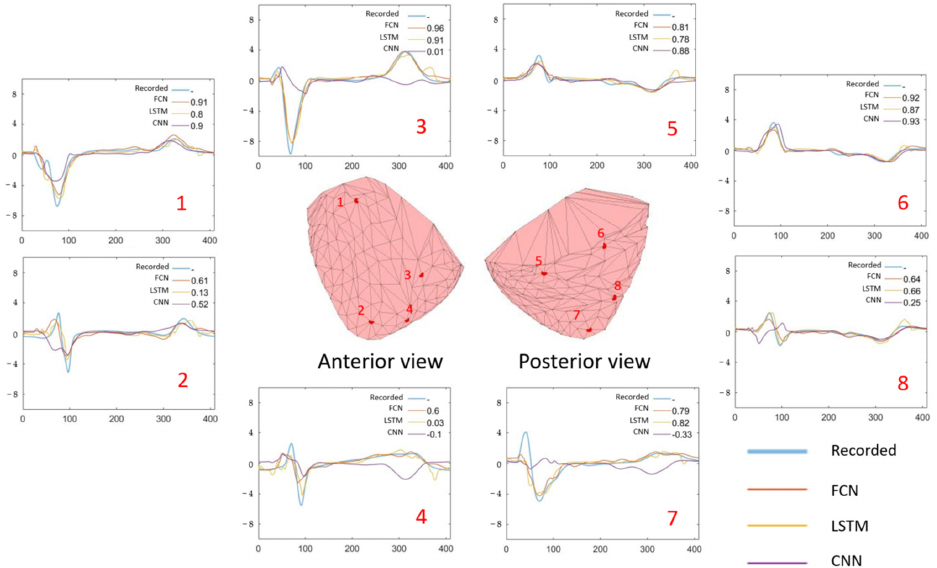
Figure 11. Examples of epicardial site electrograms (recorded and predicted). The corresponding correlation coefficients are also shown in the right upper part of the sub-graphs. The testing data shown here are the first recording from Pig 2. Graph 1–8 shows the recorded and the predicted electro-cardiac waves over 8 epicardial site as examples. The number listed over the right upper corner shows the correlation coefficient between the recorded and the predicted wave from different models. FCN: predicted result from the Fully Connected Neural network for cross-validation within the same pig; LSTM: predicted result from the Long Short-term Memory model for same-pig cross- validation; CNN: predicted result from the Convolutional Neural Network for cross-validation with different pigs.